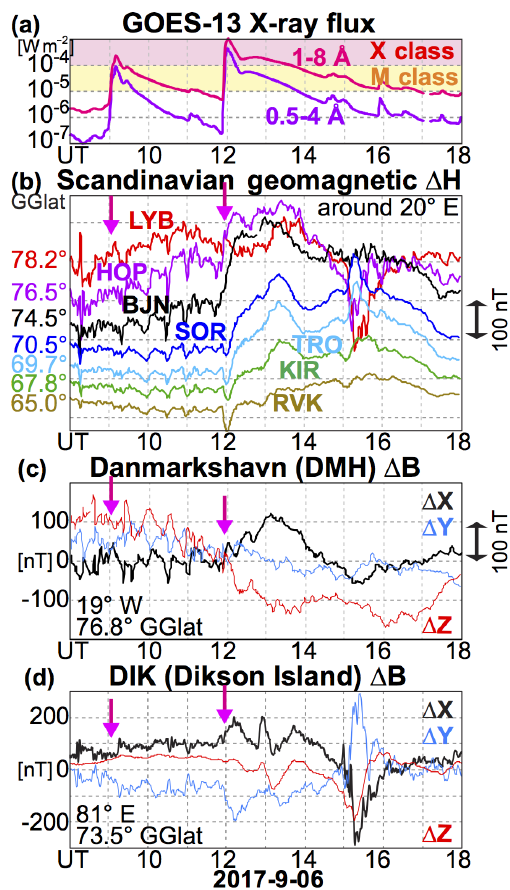
Figure 1. (a) Solar X-ray flux. (b) Stack plot of the geomagnetic D component for Kiruna (KIR) and northern Norway. (c) Geomag- netic data at Danmarkshavn (DMH) and (d) at Dikson Island (DIK).